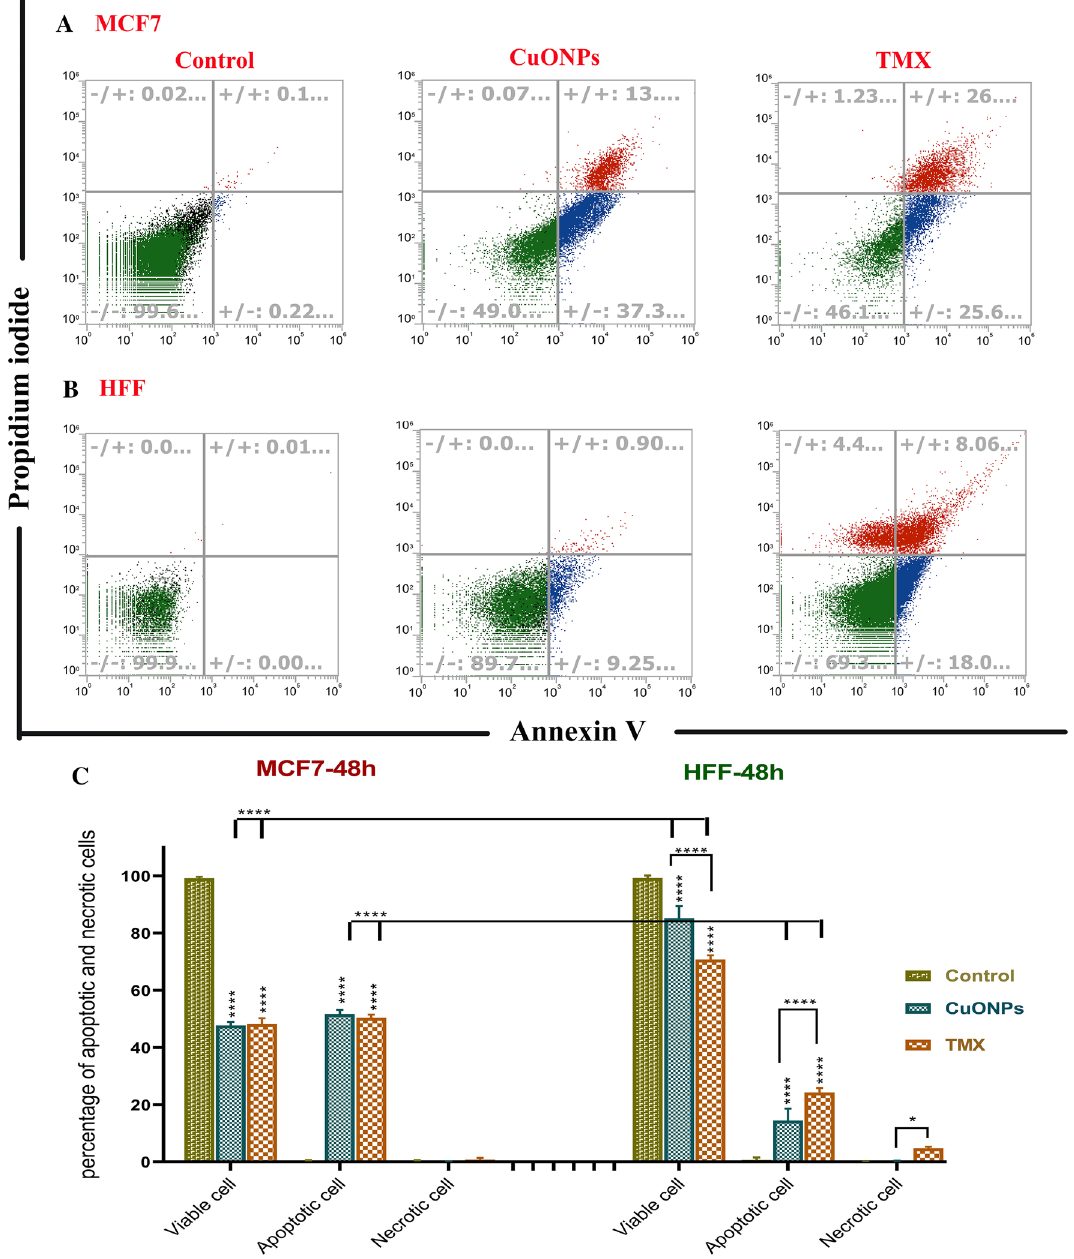
Figure 7. Apoptosis rate in ( A ) MCF7 and ( B ) HFF cells treated with IC 50 concentrations of BC-CuONPs and tamoxifen (TMX). ( C ) Comparison of apoptosis and necrosis rate in MCF7 and HFF cells treated with IC 50 concentrations of BC-CuONPs and tamoxifen after 48 h treatment. *: P < 0.05, ****: P <